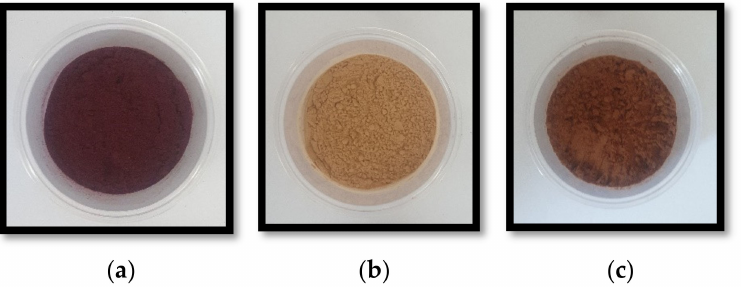
Figure 1. Appearance of the fiber preparations tested ( a ) chokeberry fiber; ( b ) apple fiber; ( c ) cocoa fiber.